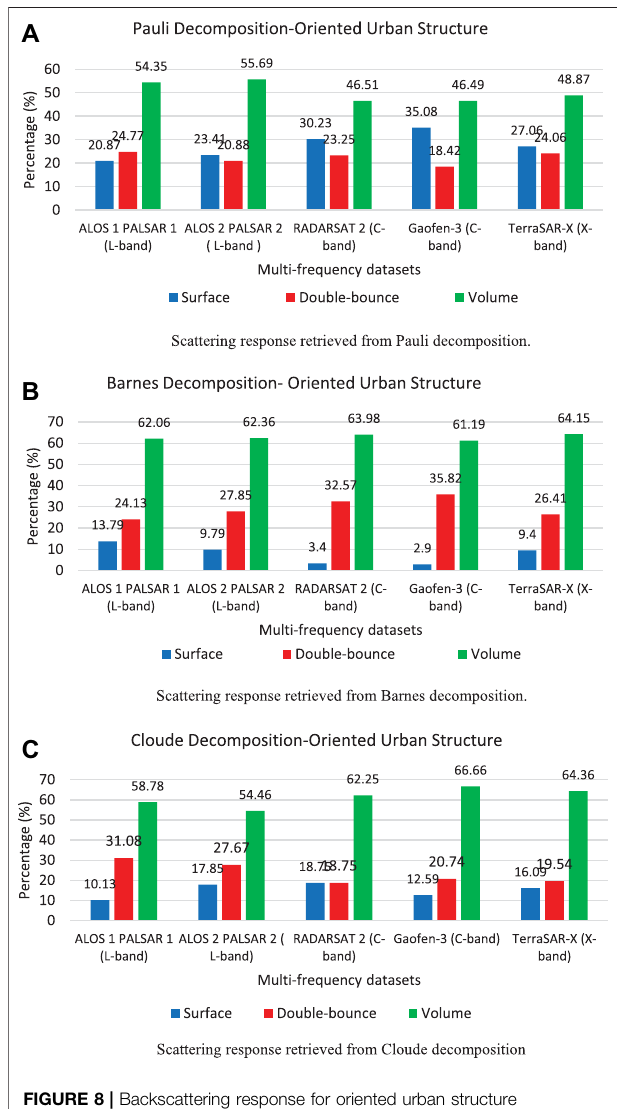
FIGURE 8 | Backscattering response for oriented urban structure obtained from Pauli, Barnes, and Cloude decomposition models. (A) Scattering response retrieved from Pauli decomposition. (B) Scattering responseretrievedfromBarnesdecomposition. (C) Scatteringresponse retrieved from Cloude decomposition.